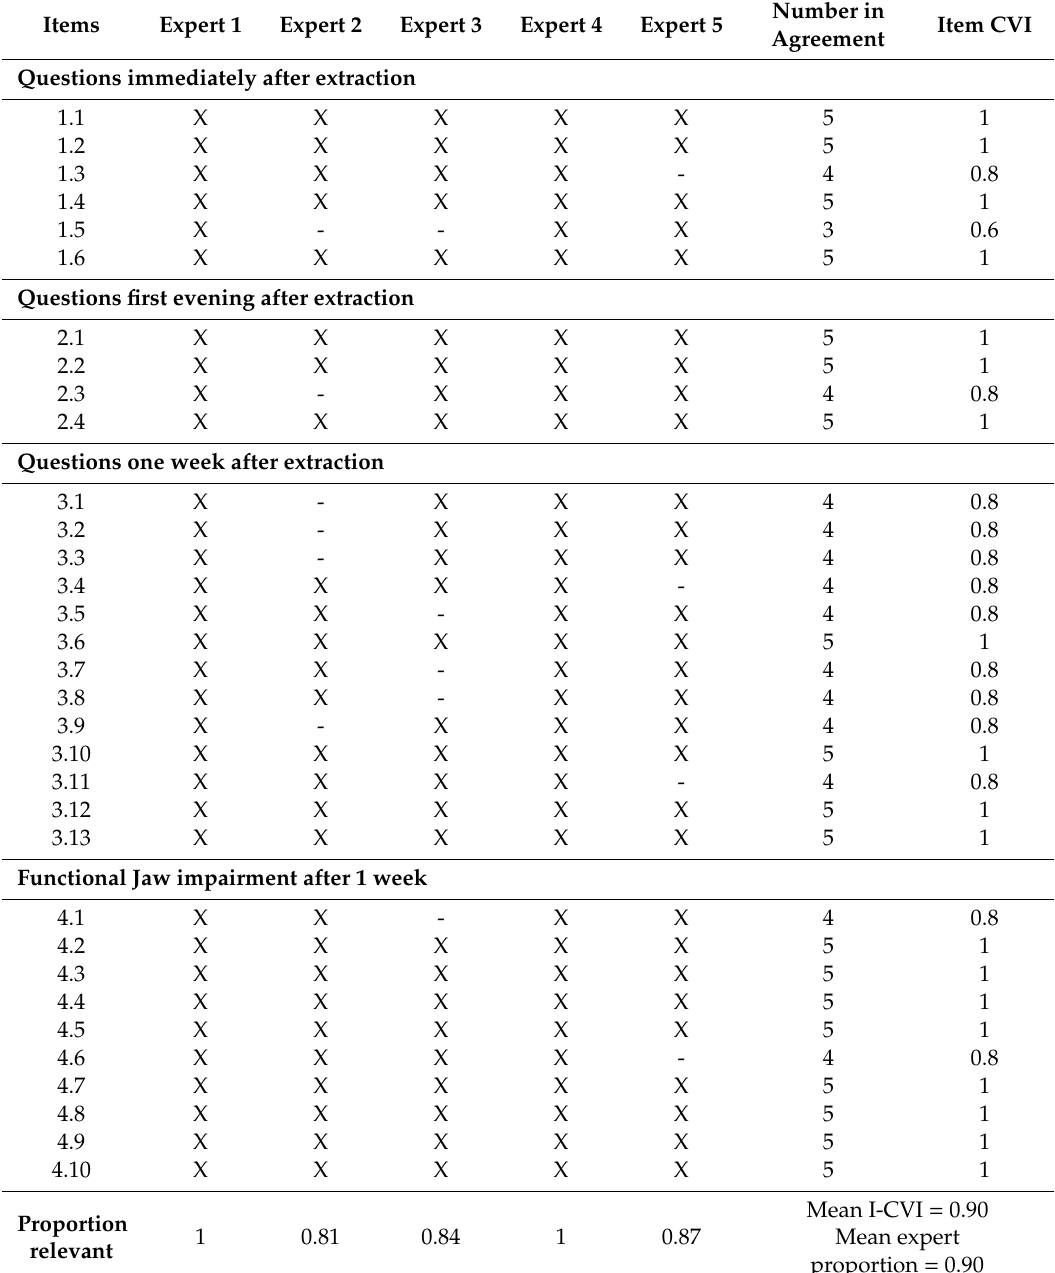
Table 4. Content validity analysis; ratings of 33-item scale by Five